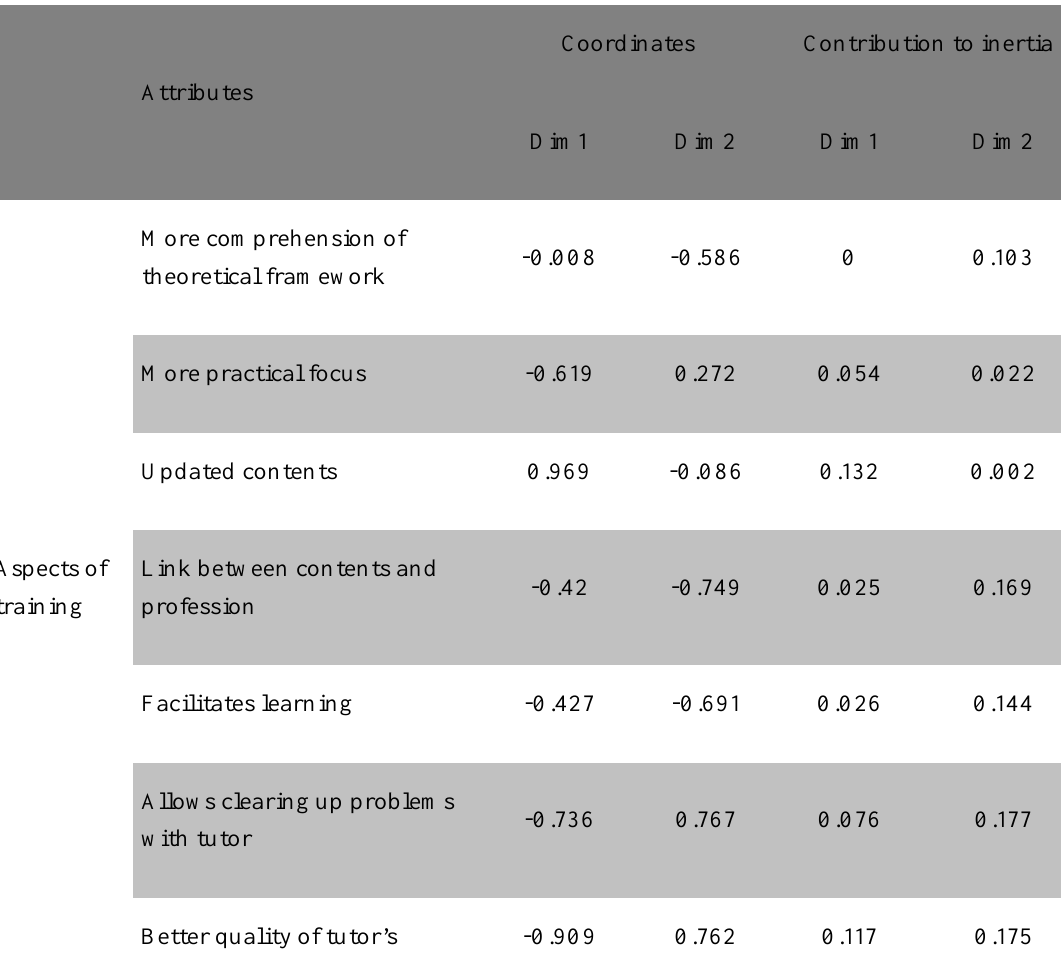
Coordinates and Contributions of the Attributes to the Inertia of Dimensions Attributes